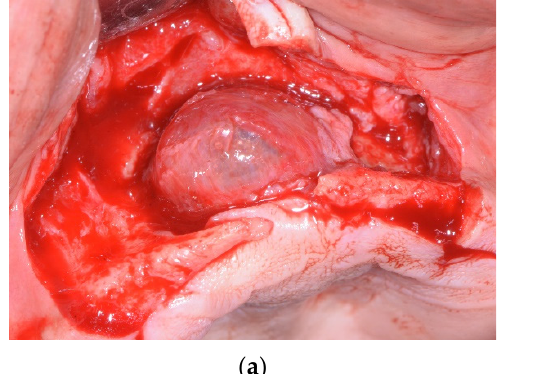
Figure 2. Cone beam computed tomography (CBCT): ( a ) frontal view; ( b ) sagittal view; ( c ) axial view; ( d ) 3D reconstruction.